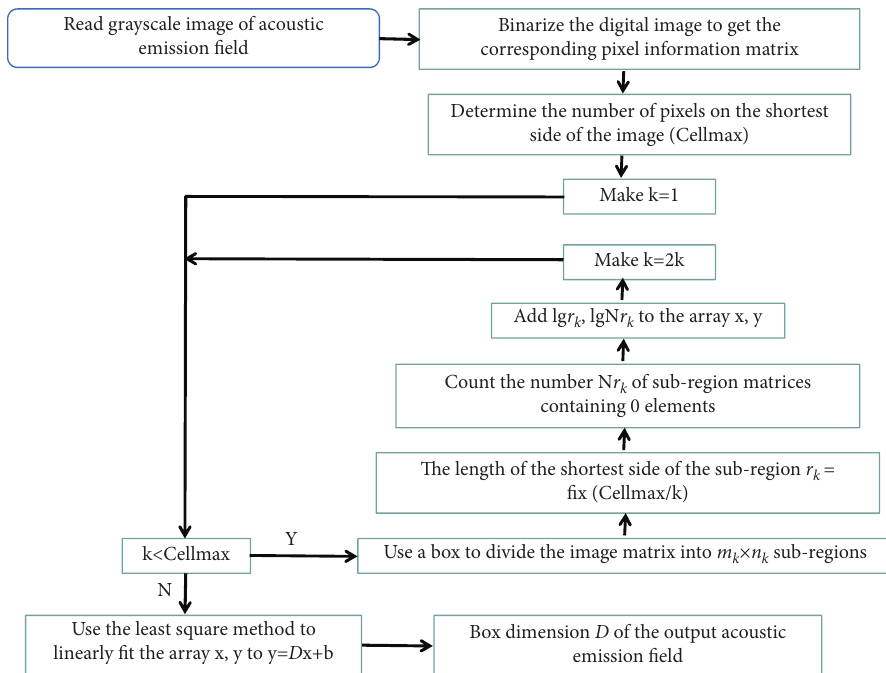
Figure 13: Calculation box dimension process of acoustic emission field based on MATLAB.